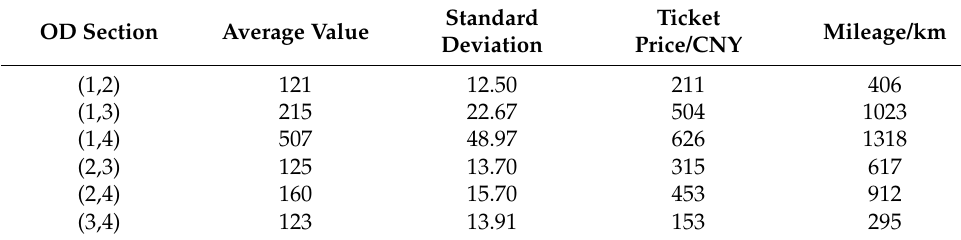
Table 3. OD Section parameter value.